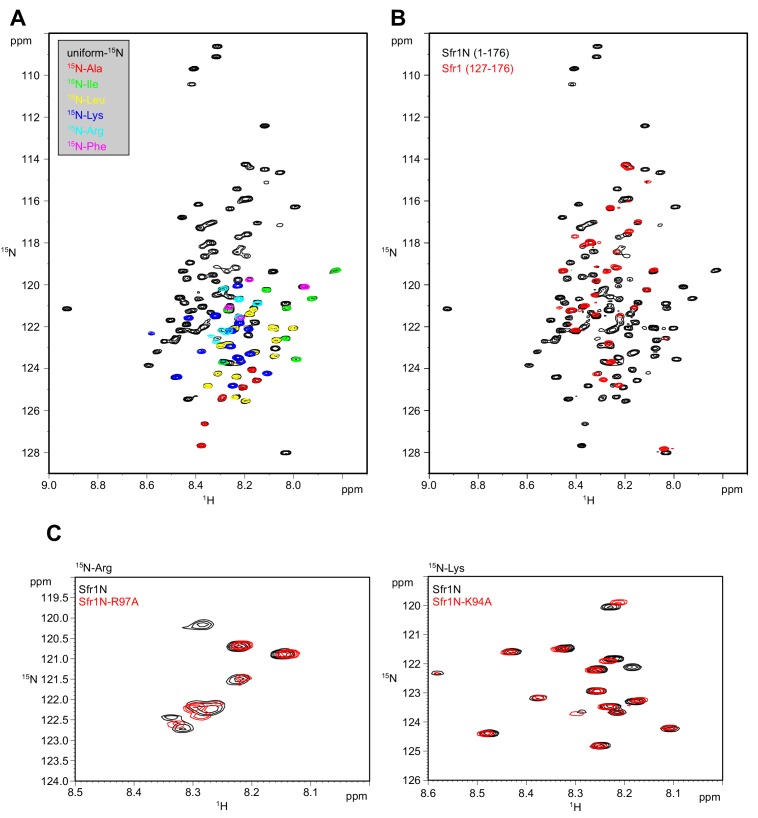
Validation of Sfr1N signals by 15N labeling.(A) Superimposed 1H-15N HSQC spectra of Sfr1N with the indicated 15N-labeling. (B) Superimposed 1H-15N HSQC spectra of uniformly 15N-labeled Sfr1N and a truncated variant, Sfr1 (127-176). (C) Left, superimposed 1H-15N HSQC spectra of Arg-selectively 15N-labeled Sfr1N or Sfr1N-R97A. Right, superimposed 1H-15N HSQC spectra of Lys-selectively 15N-labeled Sfr1N or Sfr1N-K94A.